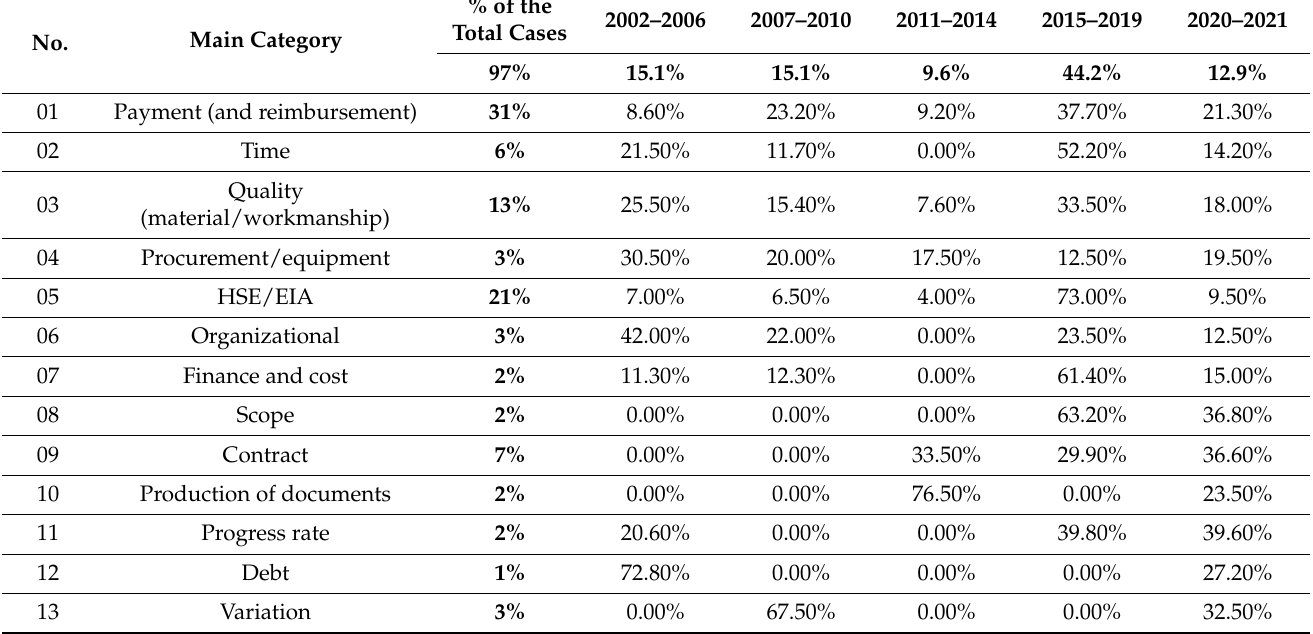
Table 3. Categorizing dispute causes in NSW construction and their relative frequency